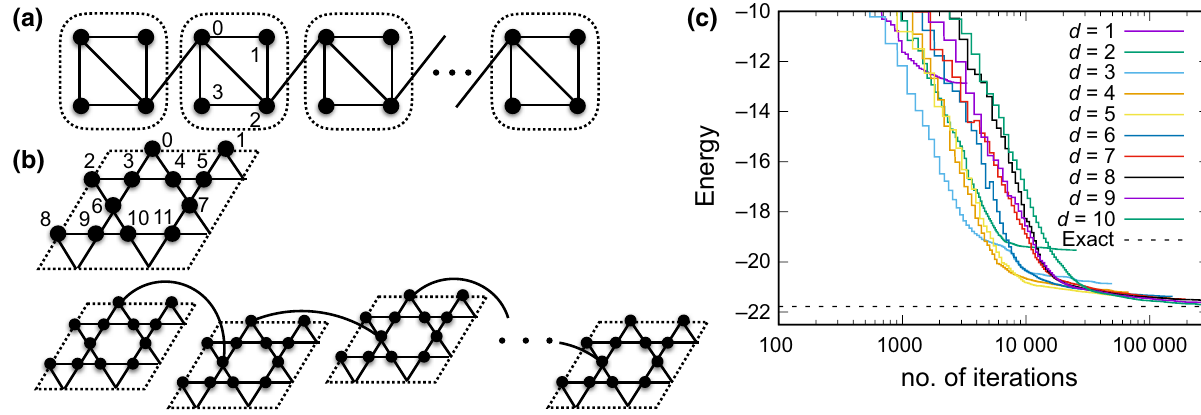
FIG. 3. (a) The system used for the numerical demonstration. It consists of four-qubit subsystems of Hamiltonian H i , each of which interacts with each other by intersubsystem interaction V ij . (b) A unit cell of Heisenberg antiferromagnetic model on a 12-qubit kagome lattice. The 12-qubit systems interact with each other in a nearest-neighbor way. (c) The energy obtained by the first VQE for the 12- qubit Heisenberg antiferromagnetic model. d indicates the depth, i.e., the number of cycles, of the parameterized quantum circuits. See Table I for the converged energies with increasing the ansatz